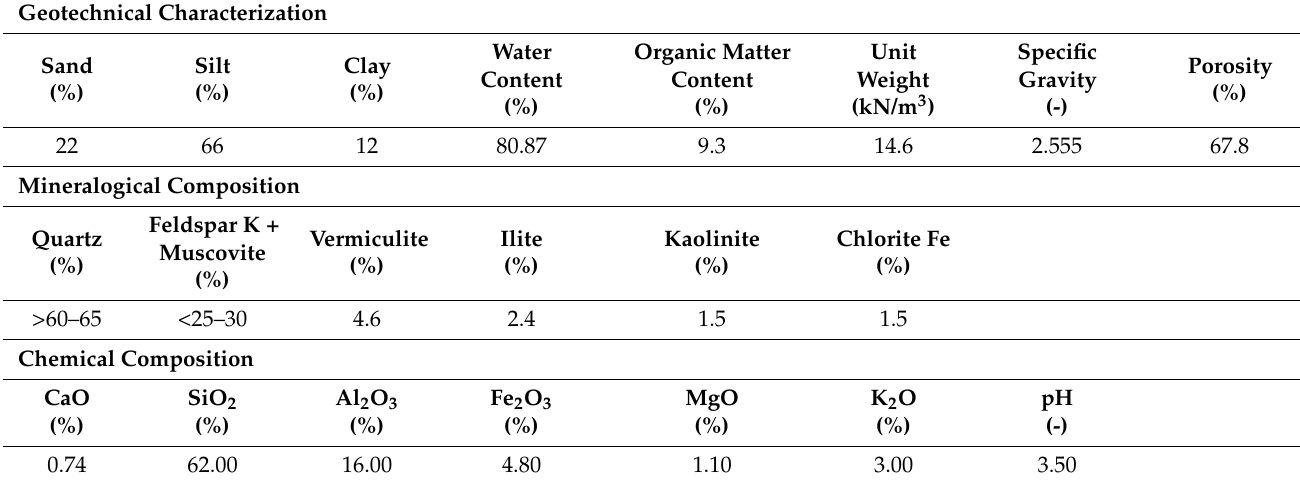
Table 3. Natural soil characteristics (average values).